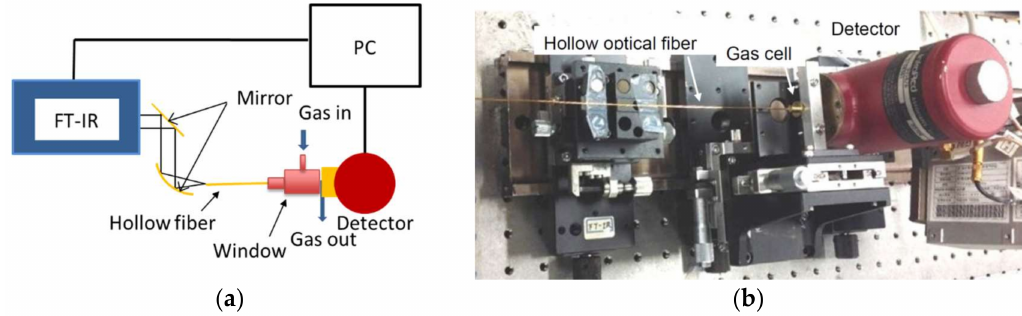
Figure 2. ( a ) Schematic and ( b ) appearance of FT-IR-based gas analysis system used for measuring absorption coefficient of CO 2 gas.